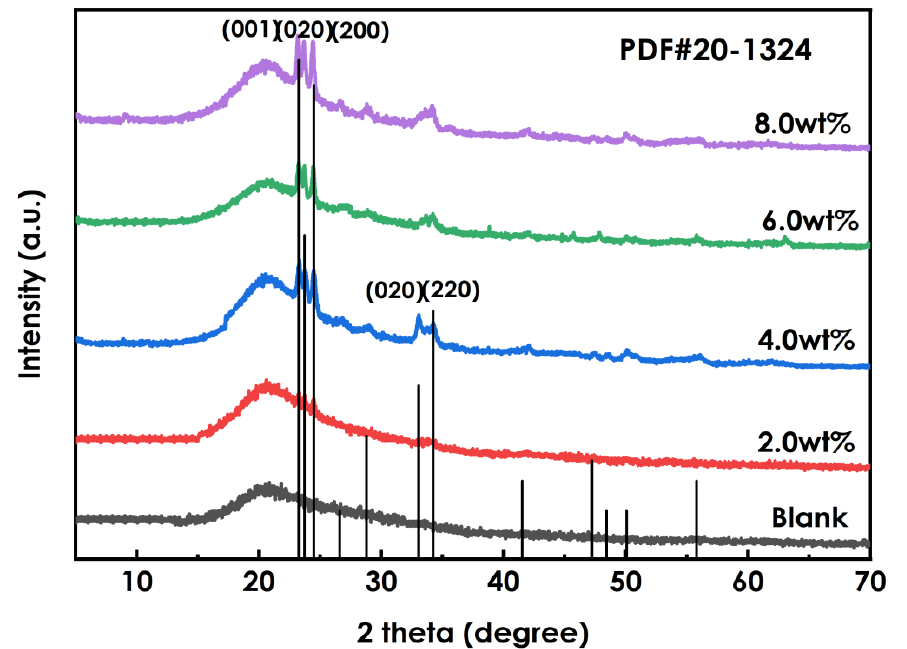
Figure 7. XRD patterns of coating using different amounts of WO 3.